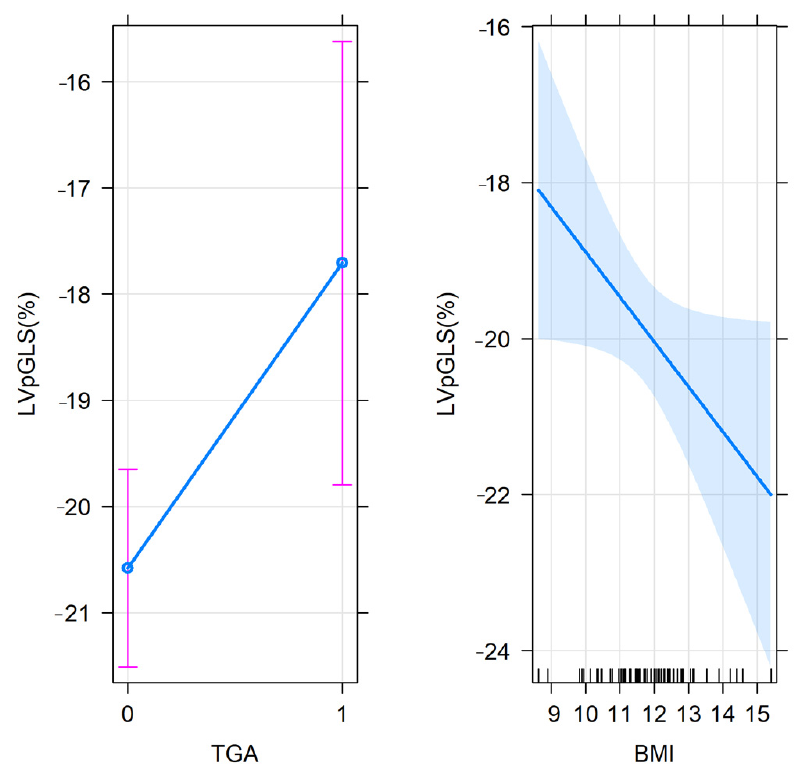
Figure 3. Predictor effect plot for TGA and BMI in the tested multivariable regression model. Note: the graph describes the partial slopes (blue line) for BMI and TGA (groups: 0 = neonates without TGA, and 1 = neonates with TGA), the pointwise confidence band for the regression fitted values (shaded area) and the error bars for the mean values of LVpGLS in the studied groups (neonates with or without TGA). LVpGLS = left ventricle peak longitudinal strain.